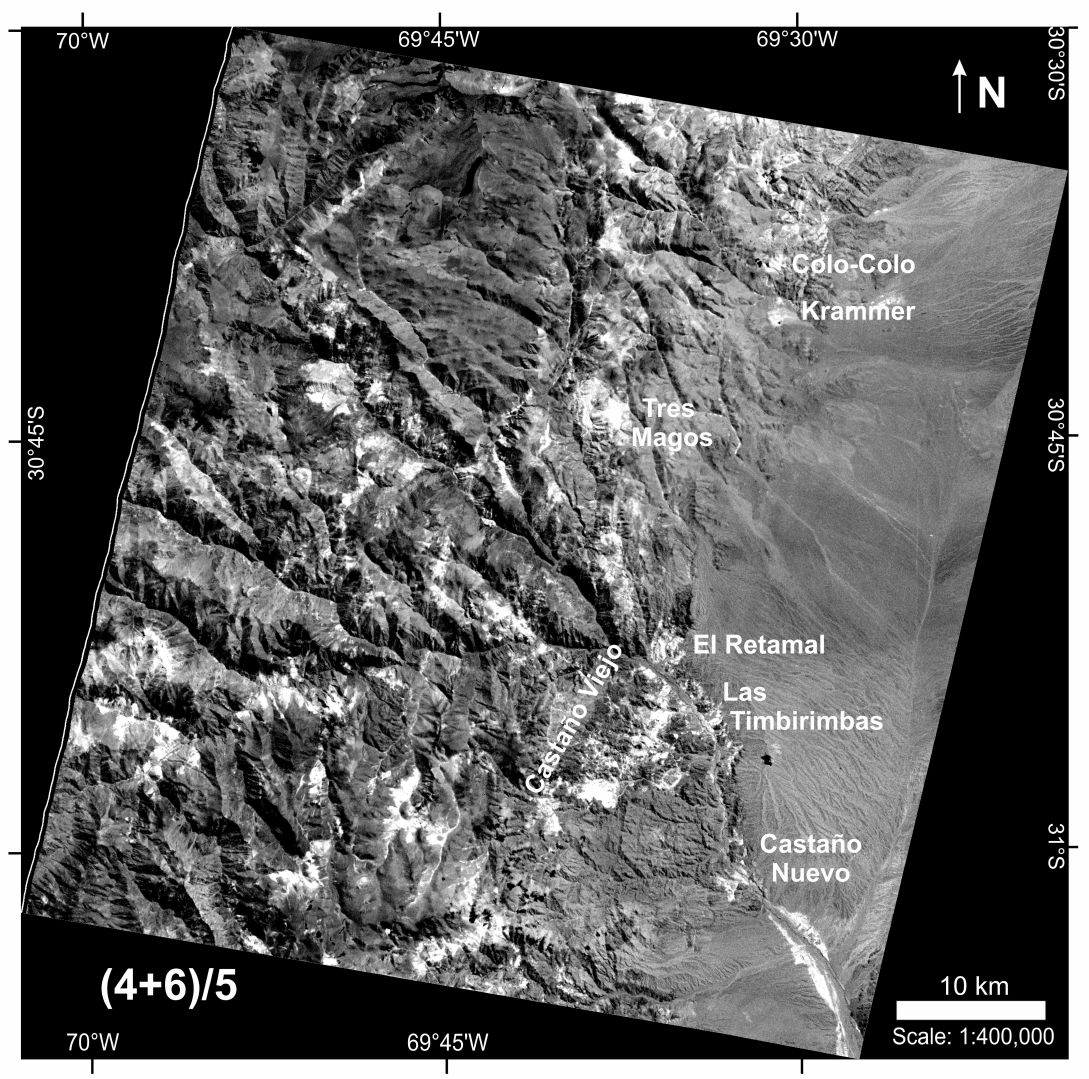
Figure A5. Grey-scale image with the ASTER band operation (4 + 6)/5. This image is particularly useful as it highlights and distinguishes the hydrothermally altered mica-rich and clay-rich areas from the mica-rich sedimentary facies of Agua Negra